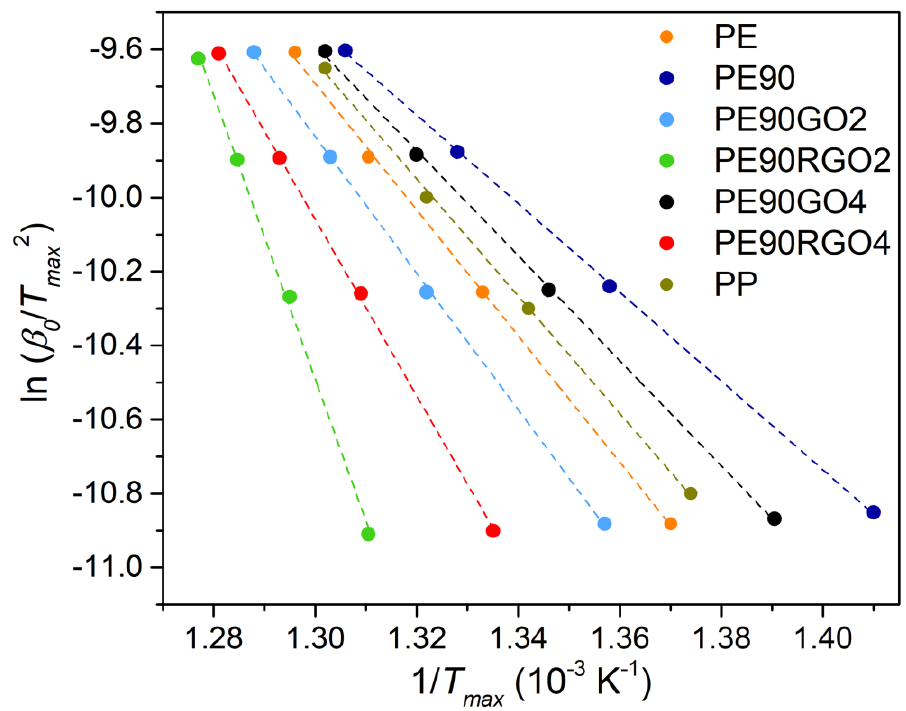
Figure 5. Kissinger plots for activation energy of thermal degradation of unfilled and filled binary systems.